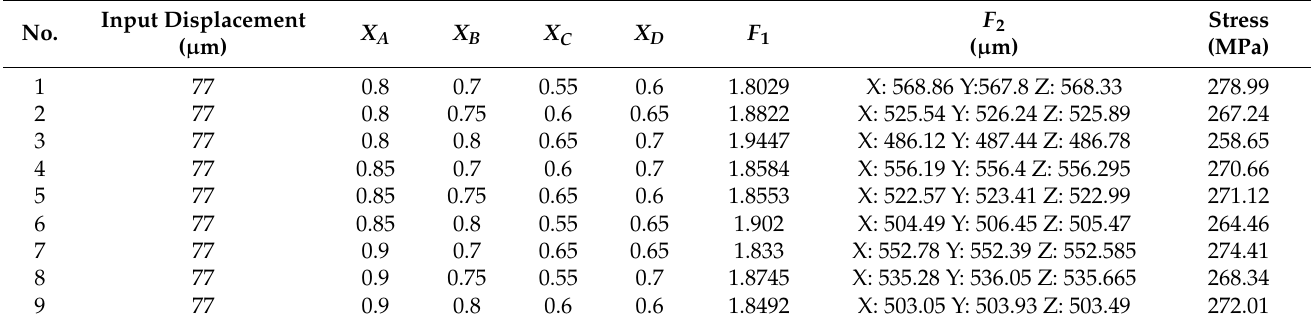
Table 2. Numerical results (Input displacement of 77 µ m).